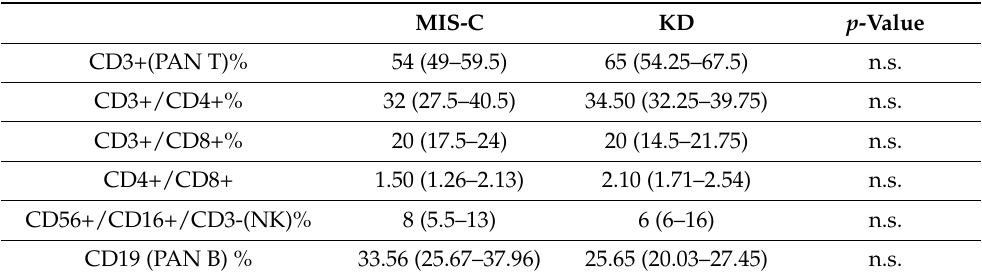
Table 3. Comparison of lymphocytes subpopulations of MIS-C and KD patients during the acute phase. Values are expressed as median